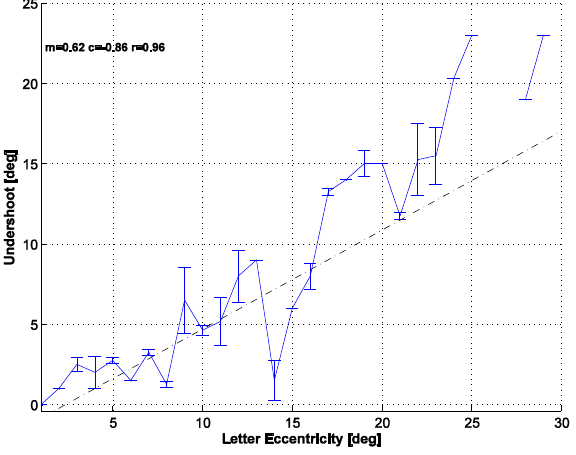
Figure 5. Landing precision (constant error) in dependence of target eccentricity for the letter-identification task, when one saccade before letter selection was carried out. Error bars = standard error of inter-observer performance.